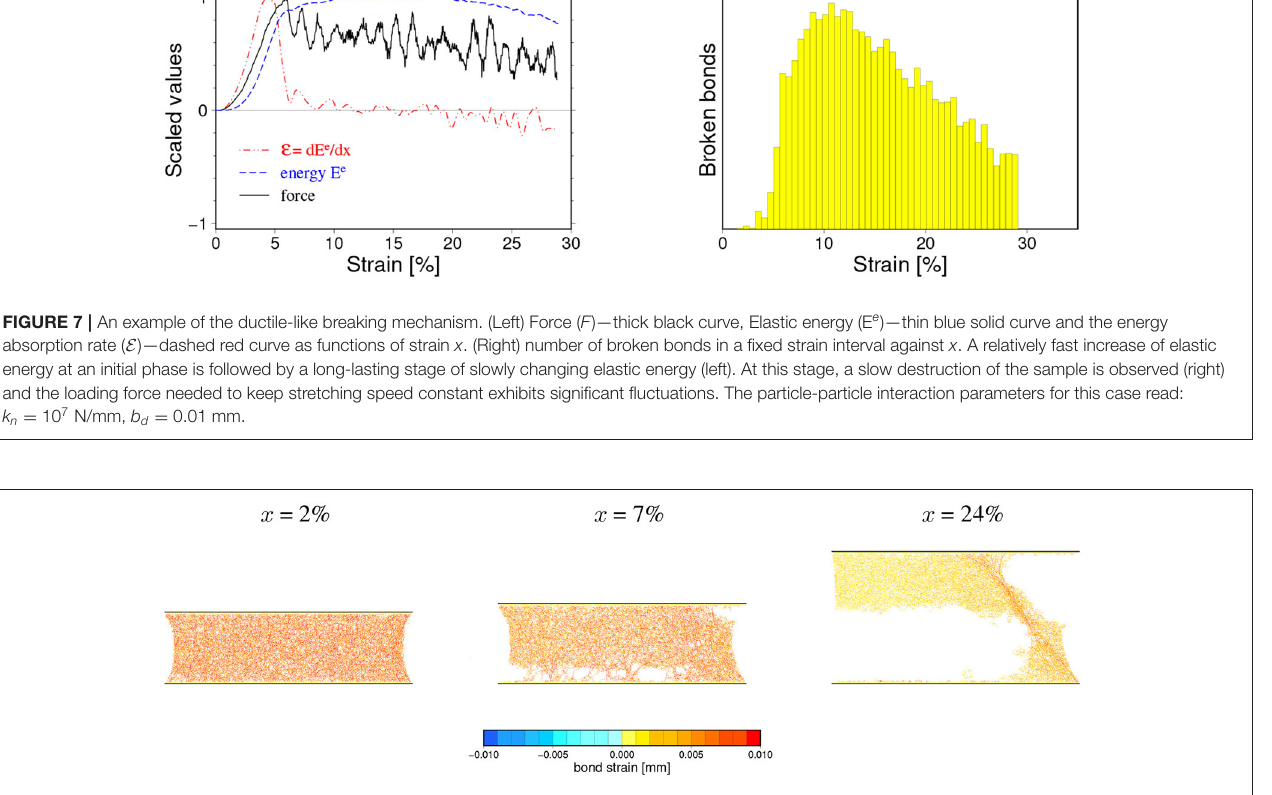
FIGURE 8 | Snapshots of the microscopic state of a sample undergoing a ductile-like breaking process at strains ( x = 2, 7, 24%) indicated above the panels. Short colored segments represent inter-particle bonds existing at a given loading stage and their extension with respect to initial values are mapped by colors. The corresponding loading curves are shown in Figure 7 .